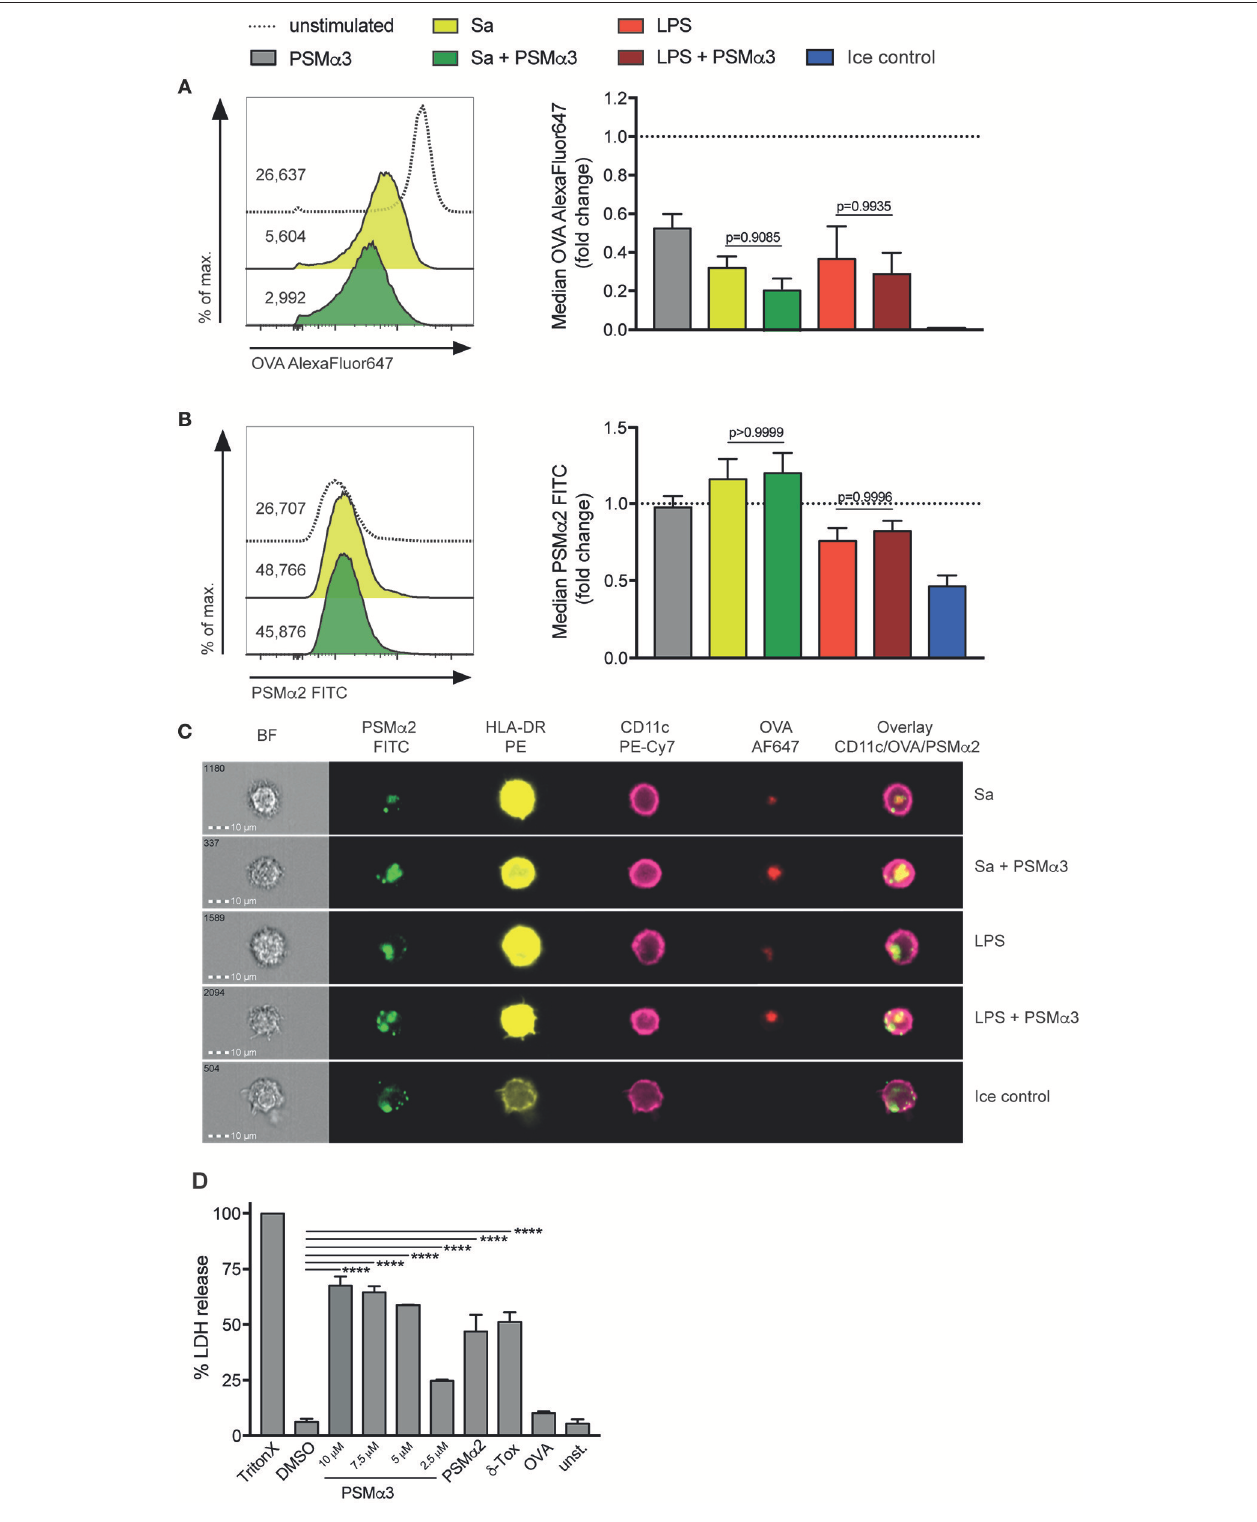
FIGURE 3 | PSMs inhibit antigen uptake by moDCs and penetrate the membrane via transient pore formation. (A–C) MoDCs treated for 24h with Sa lysate or LPS with or without PSM α 3 or PSM α 3 alone were incubated with AlexaFluor647-labeled OVA and FITC-labeled PSM α 2 at 37 ◦ C or on ice for 30min. (A,B) The uptake